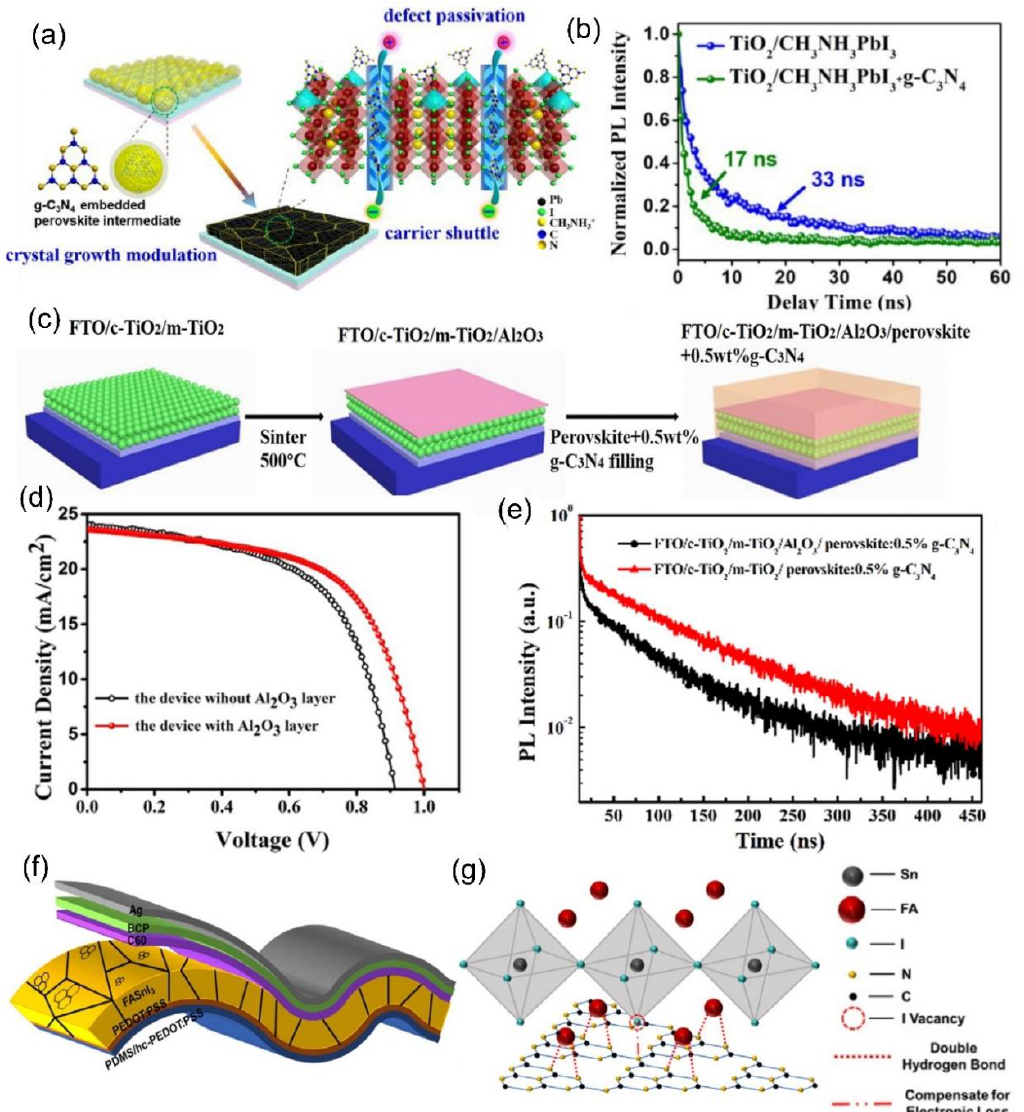
Figure 2f plots the device configuration: PDMS/hc-PEDOT:PSS/PEDOT:PSS/FASnI 3 /C 60 / BCP/Ag. The network structure of g-C 3 N 4 indicates a better lattice match with formami- dine cation, which is more conducive to the crystallization of FASnI 3 films. The illustration of bonding and passivation between FASnI 3 and g-C 3 N 4 is shown in Figure 2g. Finally, the stabilized PCE of 8.56% was obtained.